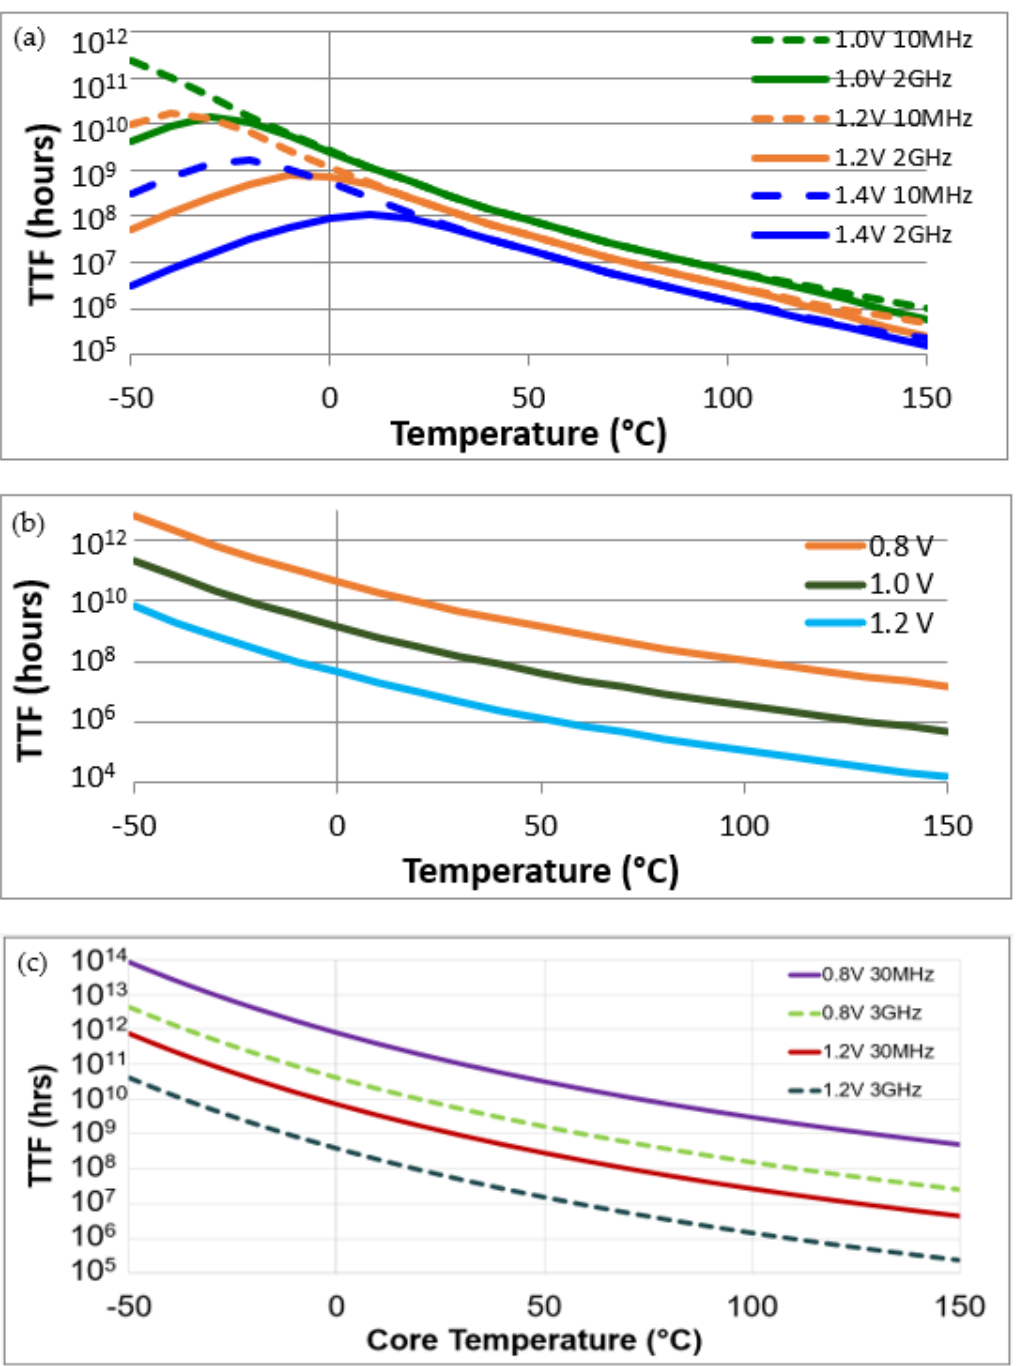
Figure 2. A display of a set of reliability profile curves for 45 nm ( a ), 28 nm ( b ), and 16 nm ( c )